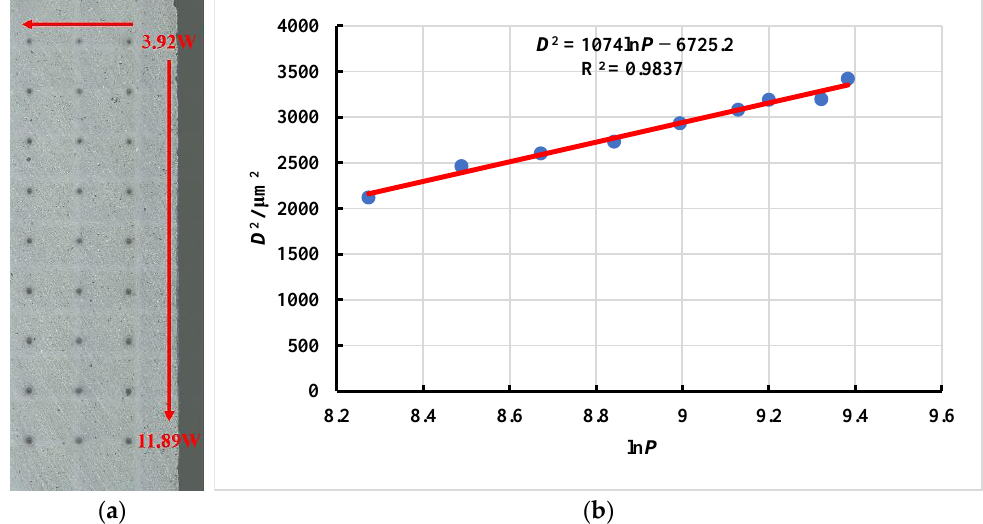
Figure 5. ( a ) The ablation hole distribution map and ( b ) the fitting line graph of the square of the equivalent ablation diameter and the logarithm of the incident laser power.